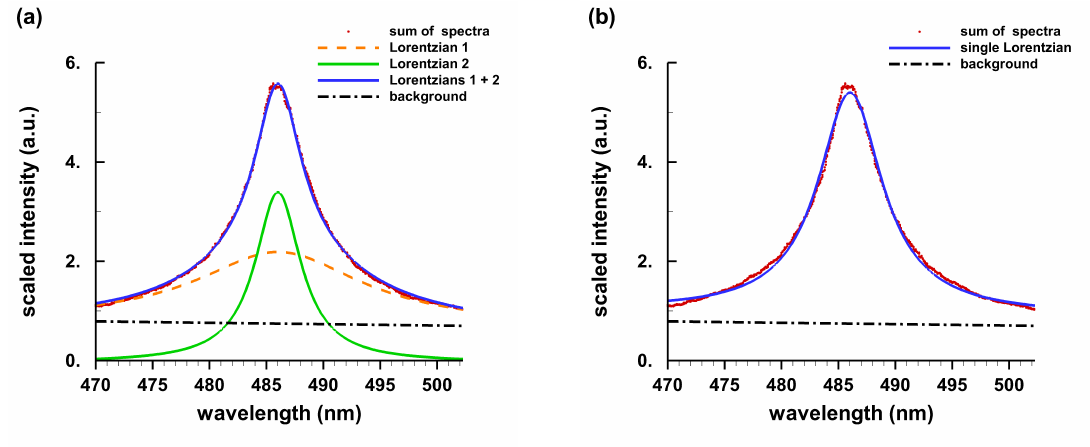
Figure 7. Fitting to summed H β profiles. ( a ) Two Lorentzians of 4.9 and 17.6-nm widths indicating electron densities of 1.1 and 5.8 × 10 17 cm − 3 , respectively. ( b ) Single Lorentzian fit of 6.9-nm width and N e = 1.8 × 10 17 cm − 3 , but with discrepancies near the wings and at